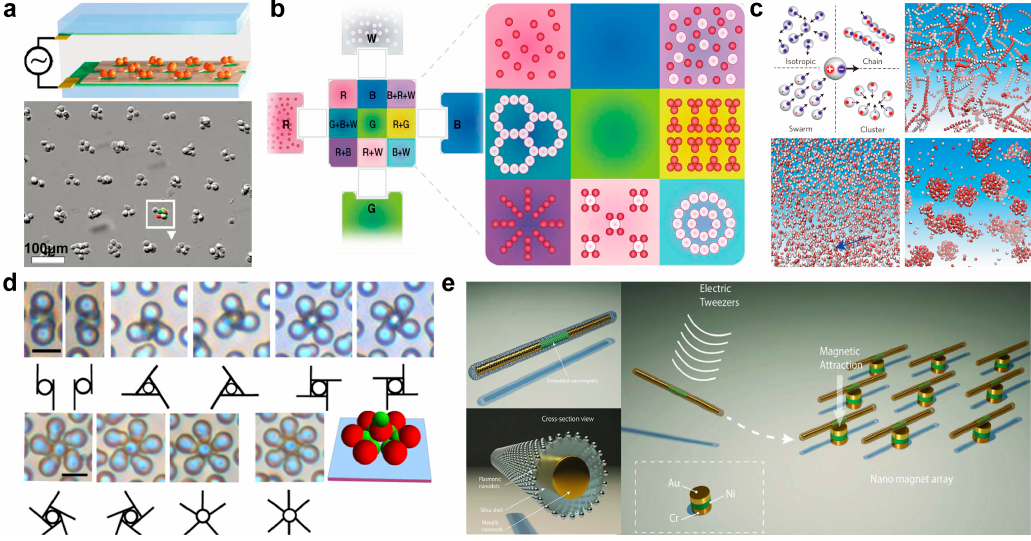
Figure 3. Electric field induced swarming and assembly of micro/nanoparticles. ( a ) Patterned electrode for multiply cell patterns (reproduced from [49]). ( b ) Programmable electromicrofluidic platform for microgel formation and architecture assembly (reproduced from [50]). ( c ) The strategy is to program dual electric charges shifted from the sphere center onto opposing hemispheres (reproduced from [51]). ( d ) Electric-field-induced assembly and propulsion of chiral colloidal clusters (reproduced from [52]). ( e ) Electric tweezers (reproduced from